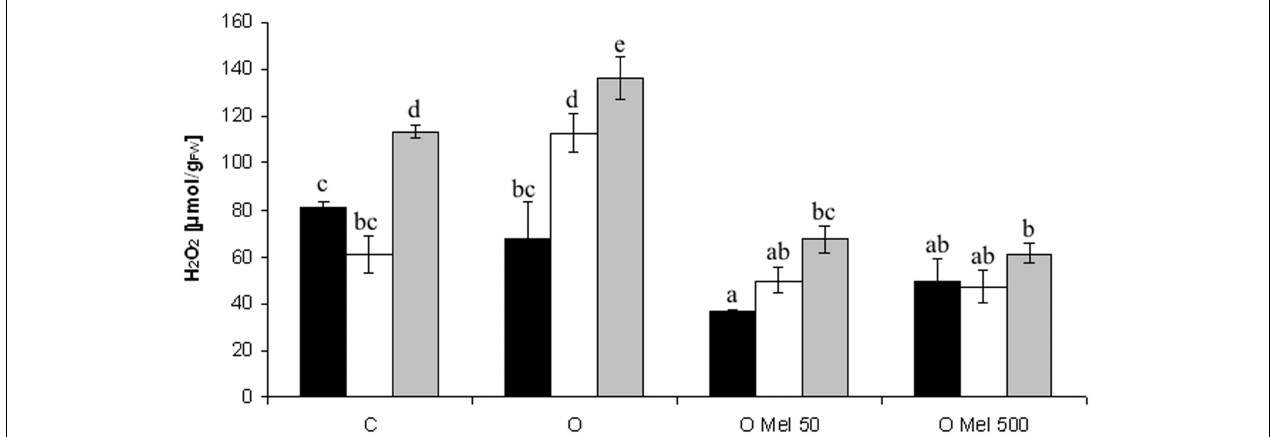
FIGURE 1 | Effect of cucumber seed osmopriming variants on hydrogen peroxide content in the axes isolated from seeds: control - untreated (C), osmoprimed without (O) and with melatonin at concentrations: 50 µ M (OMel50) and 500 µ M (OMel500). The seeds were imbibed/germinated in water at 10 ◦ C in darkness for 7 days (CS7 – (cid:3) ), and then subsequently recovered at 25 ◦ C for 2 days (R2 – (cid:4) ). Hydrogen peroxide content was also estimated in the axes isolated from the seeds germinated for 24 h under optimal conditions 25 ◦ C (to – (cid:4) ). The results are expressed as mean values of nine measurements ± SEM. Two-way ANOVA and Duncan’s post hoc test were performed. The small letters next to the values show statistical significance p < 0.001. H 2 O 2 ANOVA results: Variant (C, O, OMel50, OMel500) F (3.82) = 51.3, p < 0.001, Crucial Point (to, CS7, R2) F (2.82) = 36.6, p < 0.001 and interaction Variant × Crucial Point F (6.82) = 6.3, p < 0.001.